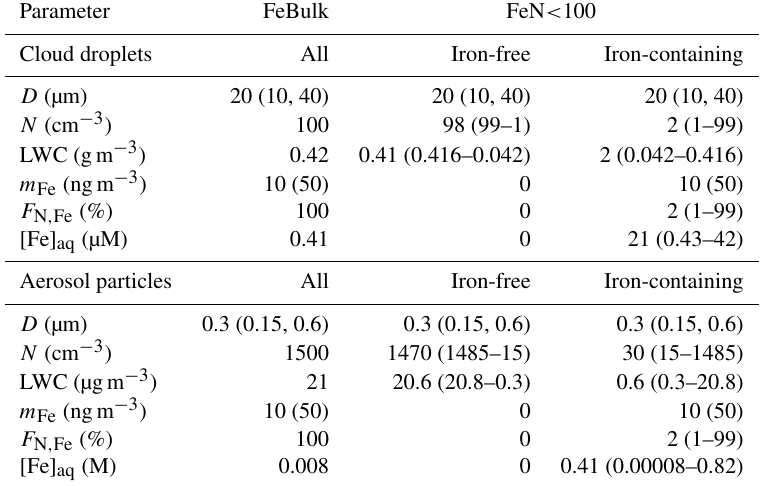
Figure 1. Model schematic. (a) FeBulk: the total iron mass concentration ( m Fe =10ngm − 3 ) is equally distributed among all droplets or particles ( F N , Fe =100%). (b) FeN < 100: the same iron mass concentration is distributed among a subset of droplets or particles (base case: F N , Fe =2%). Major ROS processes are phase transfer (blue), ROS net production (orange), ROS conversions (red) and ROS loss (black). Model parameters are summarized in Table 1. Table 1. Model parameters for multiphase simulations for cloud droplet and aerosol populations. D is the diameter, N the number concen- tration, LWC the liquid water content, m Fe the total iron mass concentration, F N , Fe the number concentration of droplets or particles that contain iron and [Fe] aq the aqueous-phase concentration of iron. Numbers in parentheses denote values or parameter ranges of sensitivity studies. Parameter